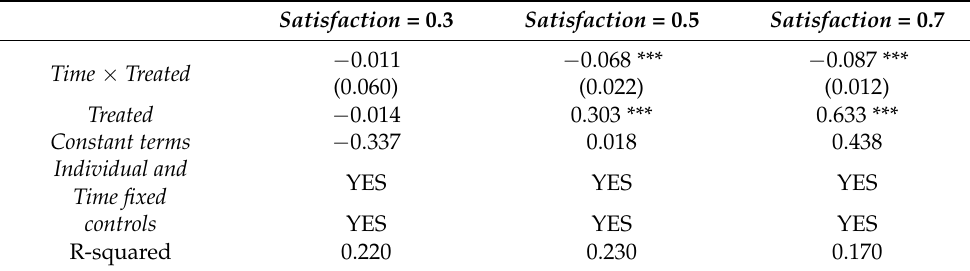
Table 6. The results of quantile regression.